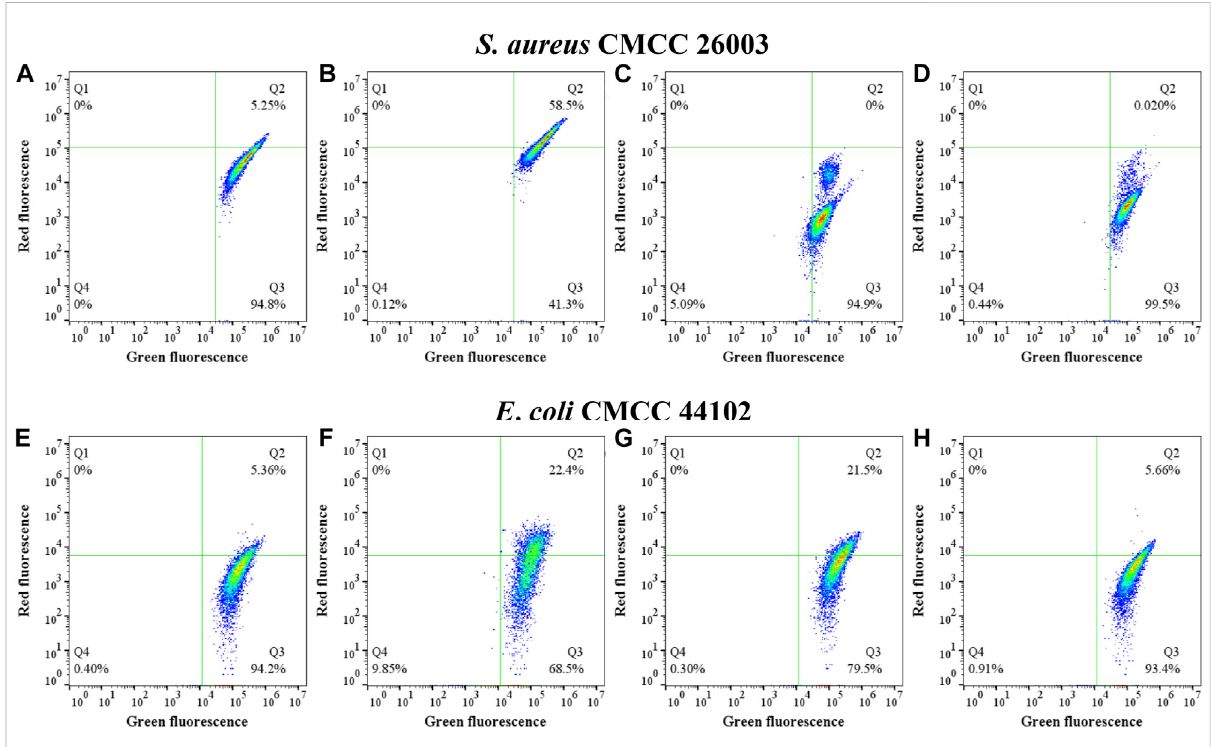
Measurement of the bacterial membrane potential of different treatments of S. aureus CMCC 26003 (A – D) and E. coli CMCC 44102 (E – H) as determined by fl ow cytometry. (A/E) CCCP+ and (B/F) CCCP − , (C/G) with 12.5 μ g/ml sanjuanolide (D/H) and 25 μ g/ml